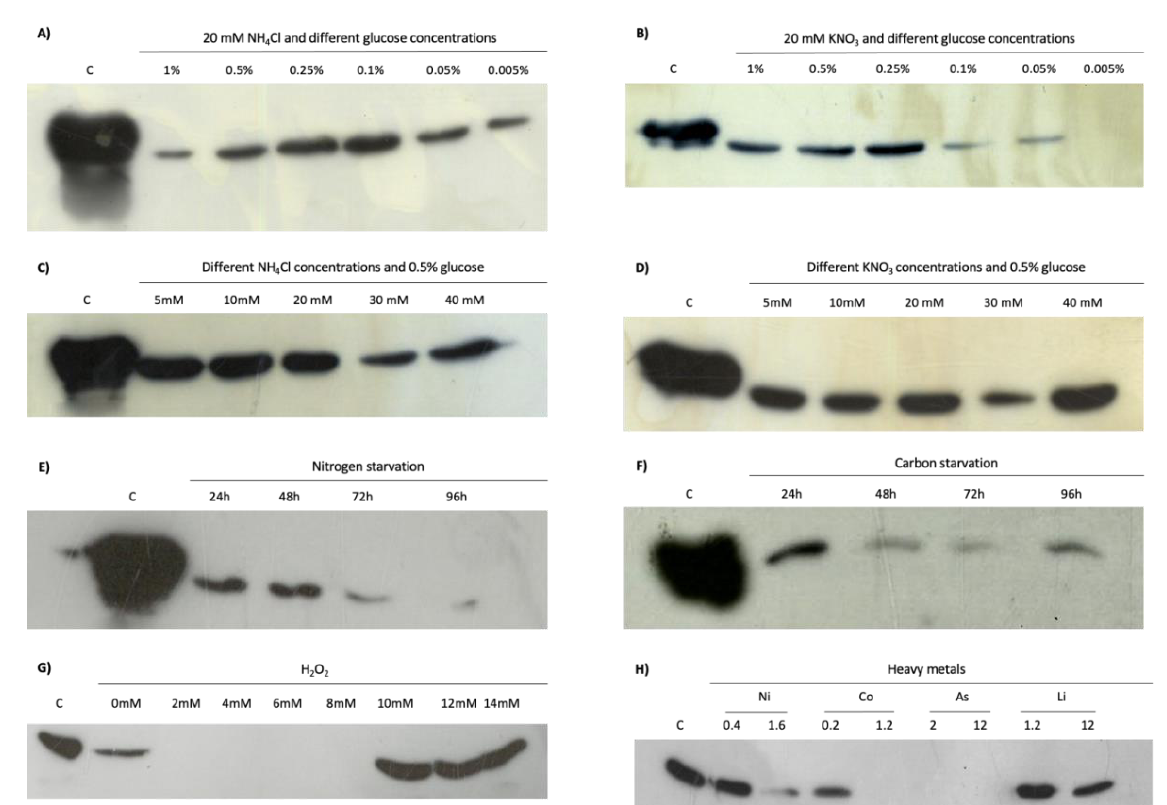
Figure 7. Western blot analysis of the presence of Lrp in cellular extracts from different culture media from Hfx. mediterranei R4. ( A ) Hm-DM containing 20 mM of ammonium as the nitrogen source and different concentrations of glucose from 1% to 0.005% as the carbon source.; ( B ) Hm-DM containing 20 mM of nitrate as the nitrogen source and different concentrations of glucose from 1% to 0.005% as the carbon source; ( C ) Hm-DM containing different concentrations of ammonium from 5 to 40 mM as the nitrogen source and 0.5% of glucose as the carbon source; ( D ) Hm-DM containing different concentrations of nitrate from 5 to 40 mM as the nitrogen source and 0.5% of glucose as the carbon source; ( E ) Hm-NS at different times of starvation (24, 48, 72 and 96 h); ( F ) Hm-CS at different times of starvation (24, 48, 72 and 96 h); ( G ) Hm-DM with hydrogen peroxide from 0 to 22 mM; ( H ) Hm-DM with Ni (0.4 and 1.6 mM), Co (0.2 and 1.2 mM), As (2 and 12 mM) and Li (1.2 and 12 mM). 40 µ g of the extract was loaded in each condition, and the control has 15 µ g of the recombinant homologous